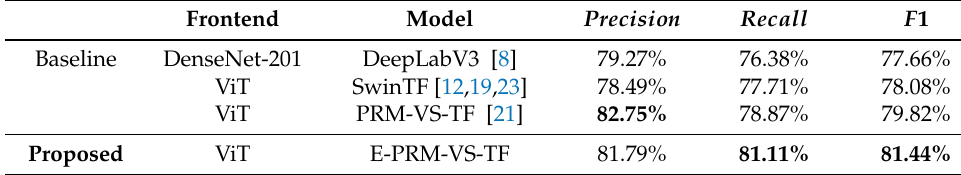
Table 1. Effect on the testing dataset of Thailand Landsat-8 challenge dataset.